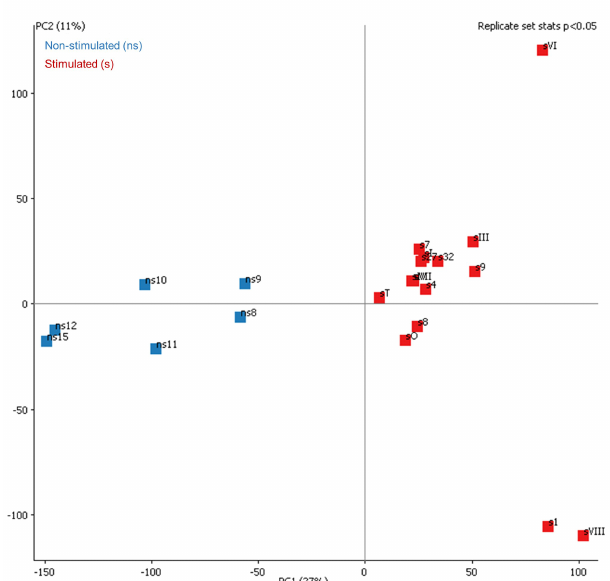
Figure 7. Principal component analysis for the 256 oocyte DMRs between a selected number of samples with higher coverage of non-stimulated and stimulated animals.